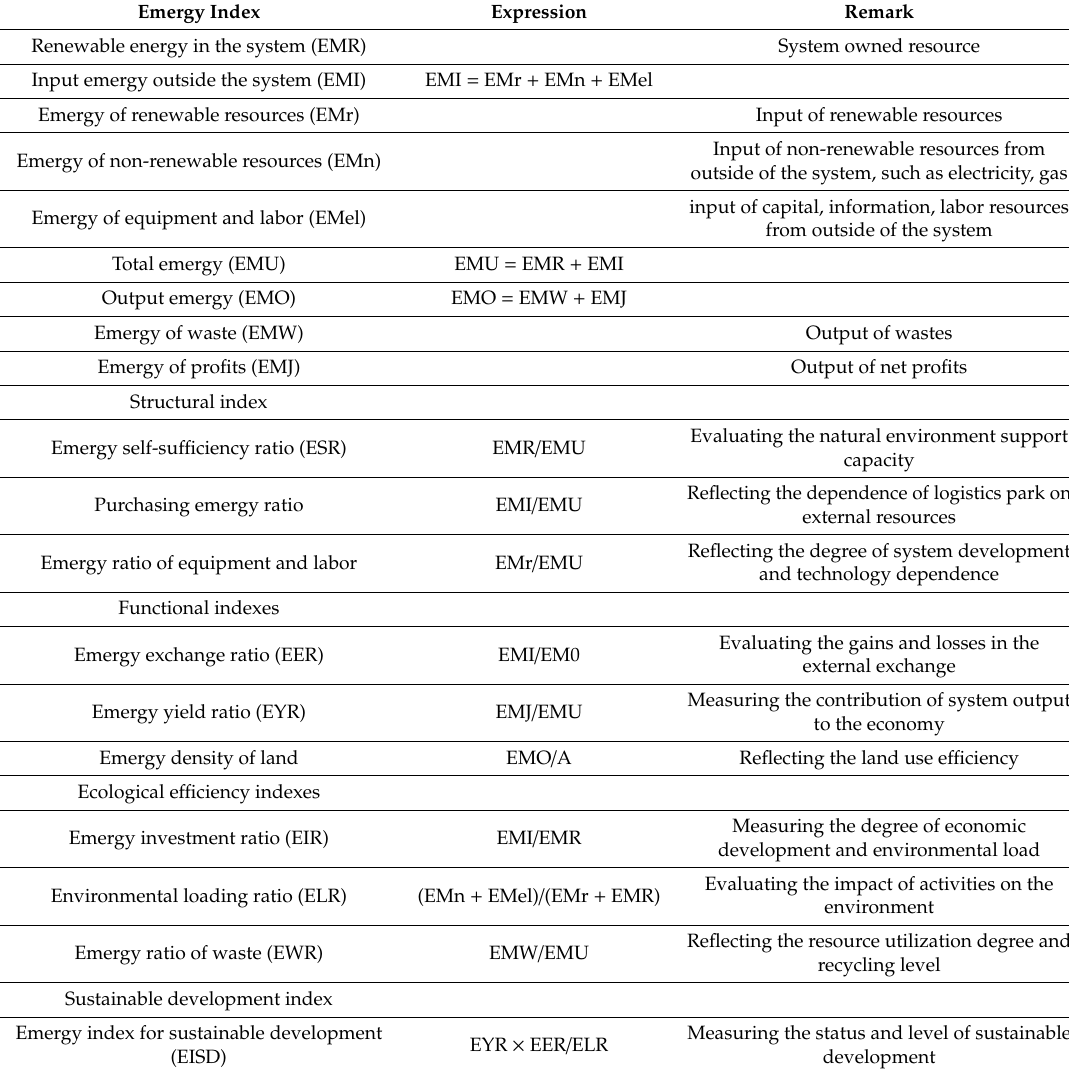
Table 1. Emergy evaluation index system of logistics